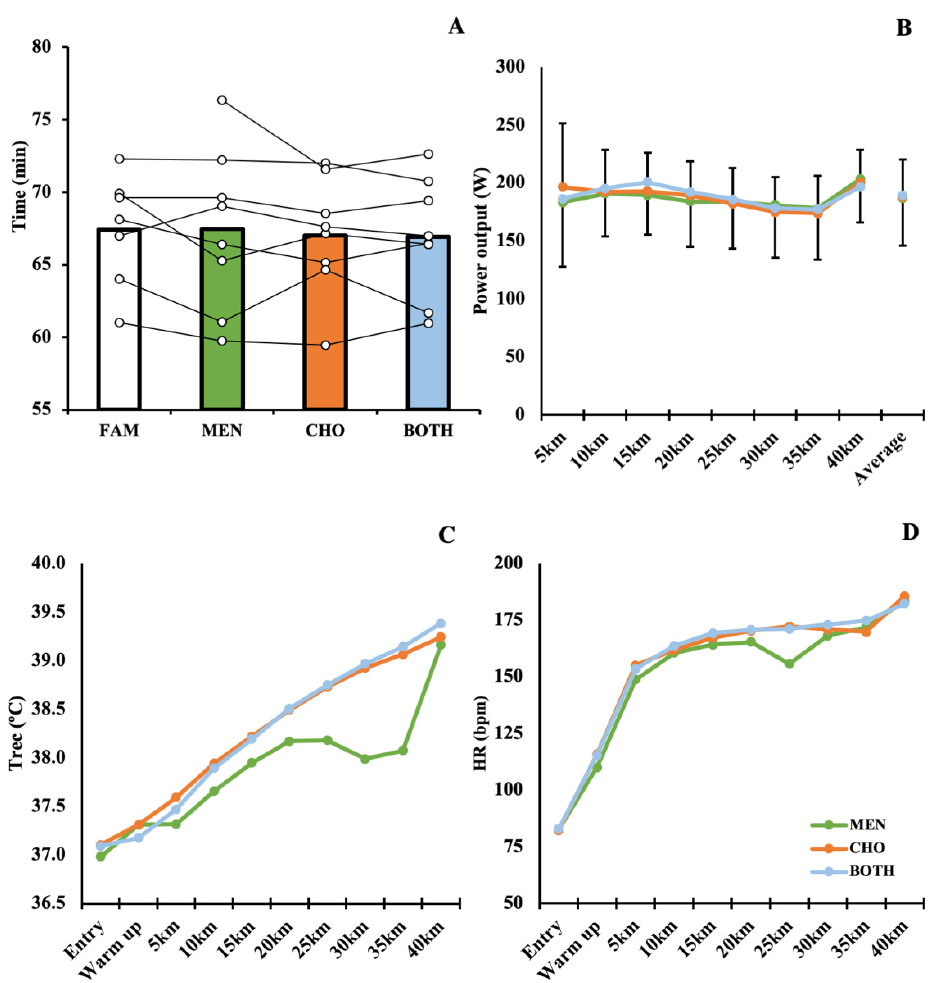
Figure 4. Mean and individual time trial performances ( A ) and mean power output ( B ) per condition. Familiarisation ( FAM ) is shown in panel ( A ) to aid in interpretation of results and support subsequent discussion. T rec ( C ) and HR ( D ) responses are presented as mean values, for each time point. Error bars are not shown in panels ( C , D ), to improve visibility of the data.